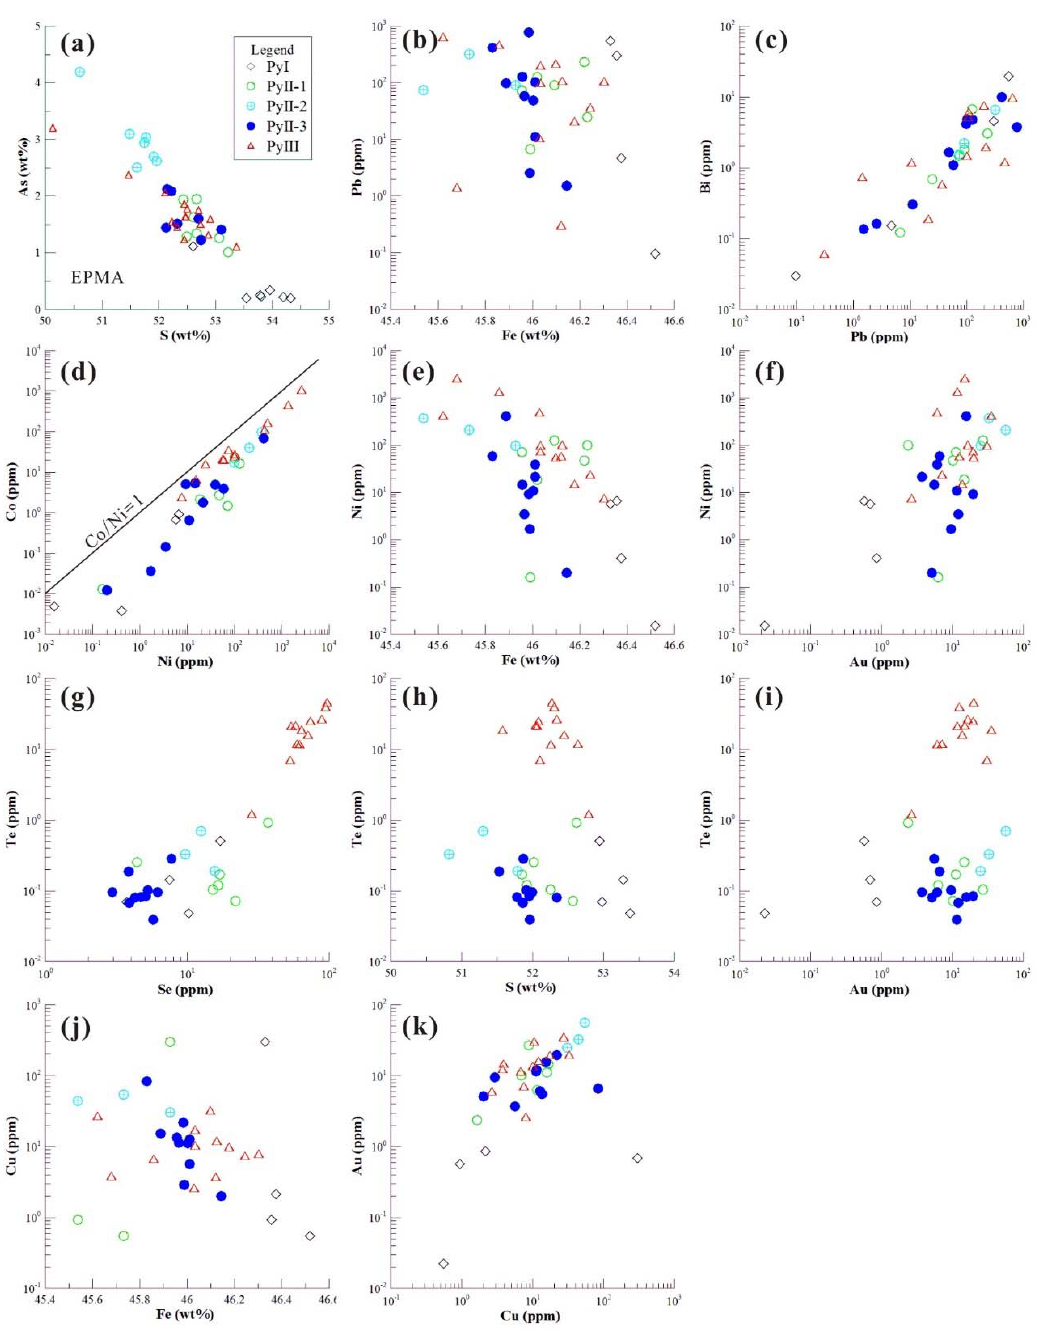
Figure 13. Binary plots of selected elements in different generations of pyrite from the Zhengchong gold deposit. ( a ) S and As data are from Table 2. Correlation between other elements from Table 3: ( b ) plot of Fe vs. Pb; ( c ) plot of Pb vs. Bi; ( d ) plot of Ni vs. Co; ( e ) plot of Fe vs. Ni; ( f ) plot of Au vs. Ni; ( g ) plot of Se vs. Te; ( h ) plot of S vs. Te; ( i ) plot of Au vs. Te; ( j ) plot of Fe vs. Cu; ( k ) plot of Cu vs. Au.